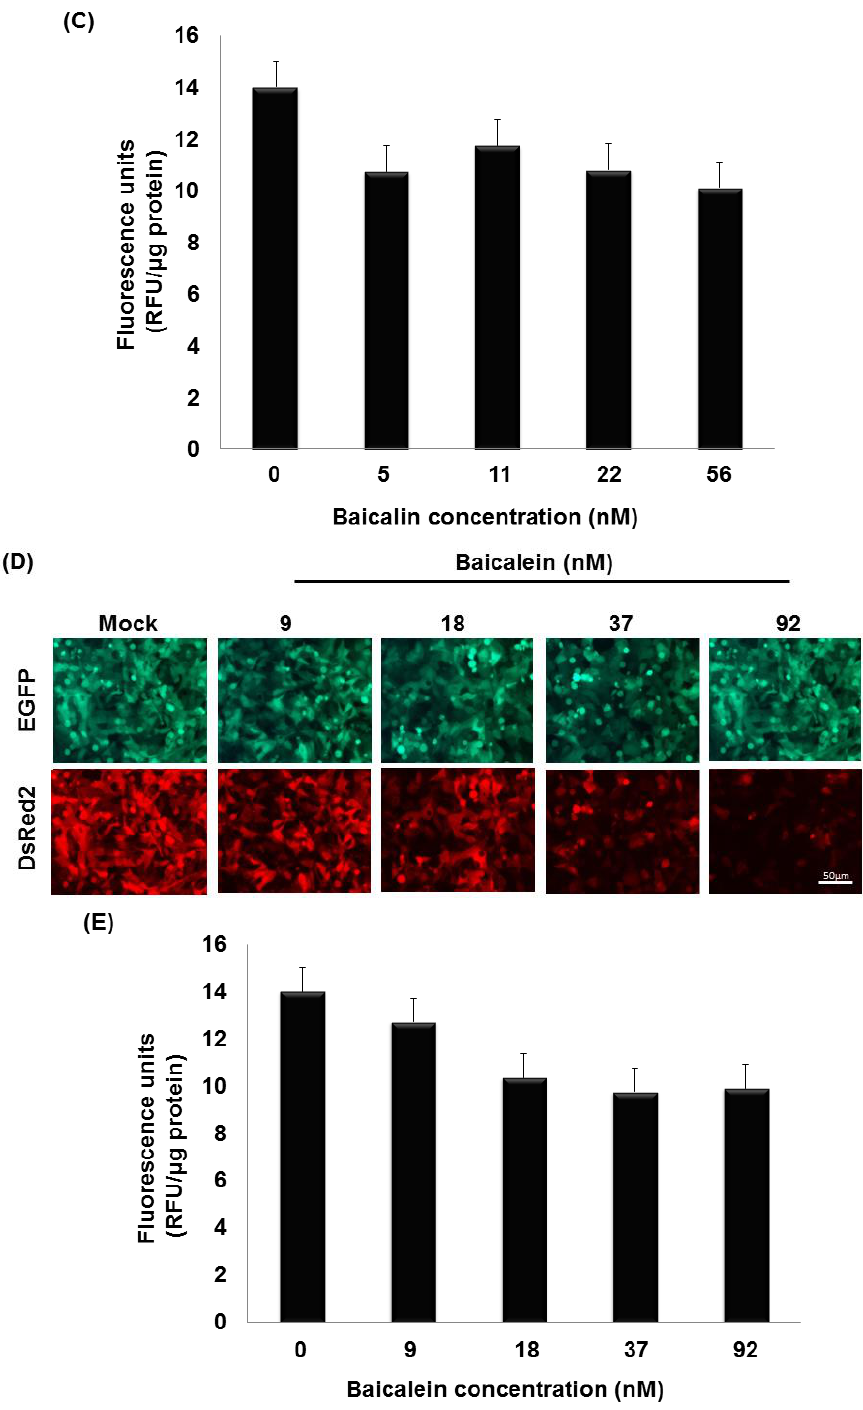
Figure 9. Schematic presentation of the BacMam vector with a CMV promoter and its effects on plant-derived compounds. ( A ) vAc-CMV-DsRed2-Lir-EGFP BacMam vector contain CMV to control the expression of the reporter genes DsRed2 and the EGFP flanking with Lir. DsRed2, Red fluorescent protein; Lir, a chimeric IRES; and EGFP, enhanced green fluorescent protein gene. ( B ) Effects of baicalin on vAc-CMV-DsRed2-Lir-EGFP BacMam-mediated reporter genes expression in U-2OS cell at different concentrations. The bar represents 50 µm. ( C ) DeRed fluorescent quantitation of different concentrations of baicalin on BacMam-mediated CMV promoter activity in U-2OS cells. ( D ) Effects of baicalein on vAc-CMV-DsRed2-Lir-EGFP BacMam-mediated reporter genes expression in U-2OS cell at different concentrations. ( E ) DeRed fluorescent quantitation of different concentrations of baicalein on BacMam-mediated CMV promoter activity in U-2OS cells. For ( C,E ) the wavelength of emission was monitored at 583 nm and excitation stimulated at 558 nm. All data were replicated 3 times.